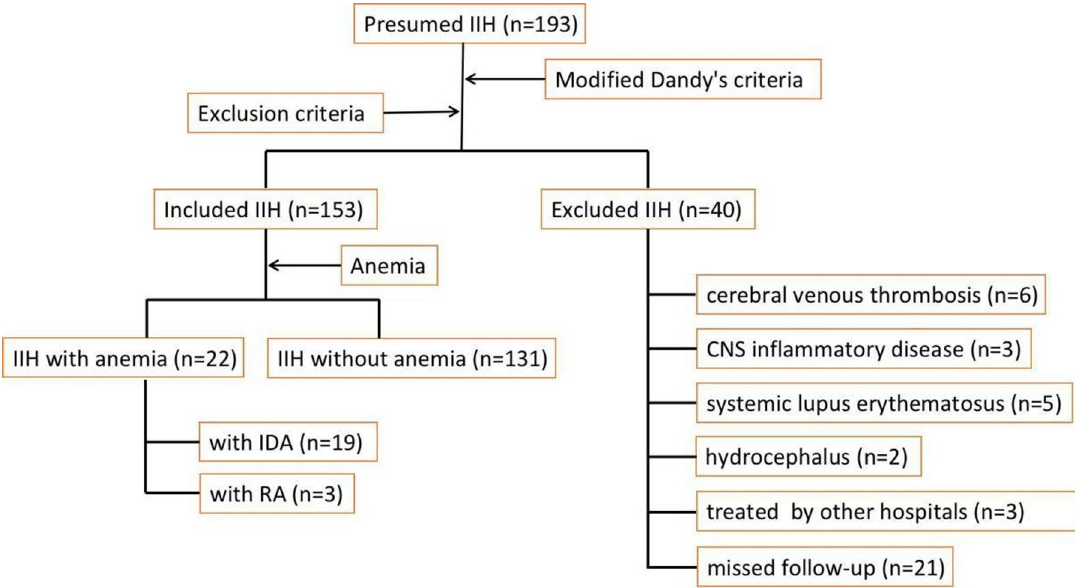
Fig 1. Flow chart of cases’